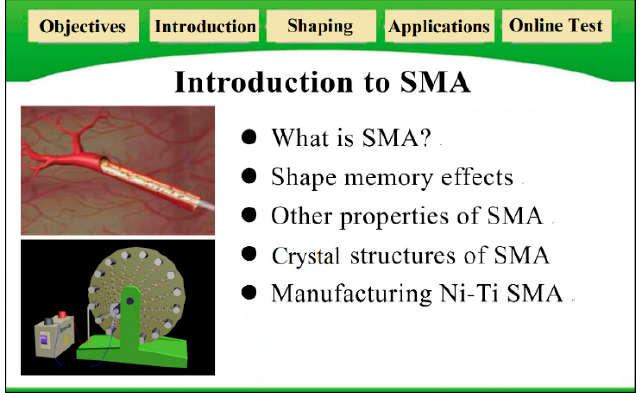
Figure 11. Learning the basic concepts of SMA.